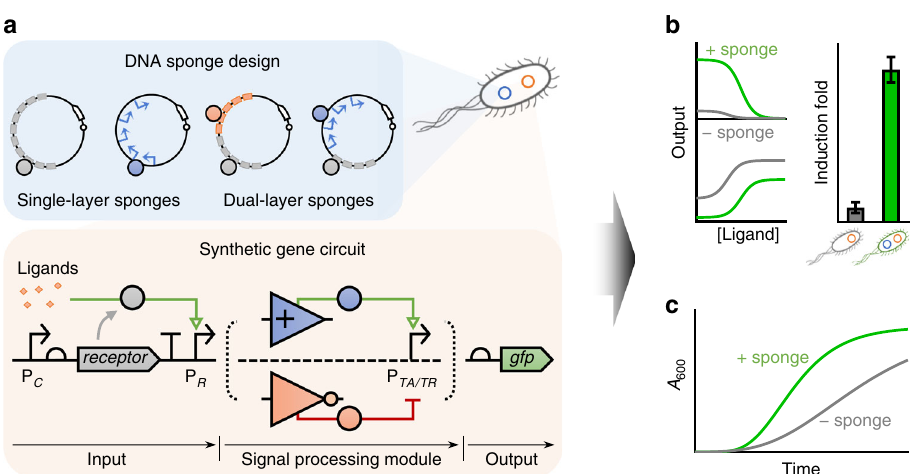
Fig. 1 Schematic showing DNA sponge as a ubiquitous tool to tune gene expression and mitigate protein toxicity for gene circuit engineering. a Design of DNA sponges (in blue, top) to tune the response of a target gene circuit (in orange, bottom). A synthetic gene circuit typically comprises an input sensing module, an optional signal processing module (e.g., a transcriptional ampli fi er or inverter) and an output module for initiating physiological responses. Here in the input sensing module, a constitutive promoter (P C ) drives the expression of a receptor gene that responds to target ligands and regulates its cognate promoter P R . In a typical signal processing module, the P R drives the expression of a transcriptional activator (TA, blue solid circle) or repressor (TR, orange solid circle), which then controls its cognate promoter P TA/TR to express an output protein (e.g., GFP). The DNA sponge is designed to harbor one or multiple protein binding sites (rectangles) or cognate promoters (arrows) of the receptor or TA/TR in the target circuit. b , c Diagrams showing the effects of the sponge regulation on the circuit ’ s output response ( b ) and growth burden on the host ( c ). With the presence of different DNA sponges (green line/bar) for the receptor, TA or TR, the circuit ’ s basal output expression can be reduced, leading to increased induction fold. In addition, the sponge can absorb excess toxic transcriptional regulators, leading to improved host cell